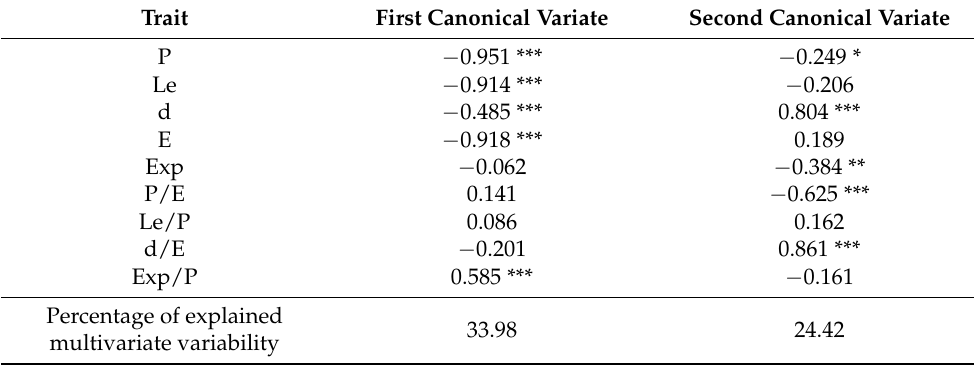
Figure 7. Heatmap for Pearson’s correlation coefficients between observed traits (r cr = 0.232) for Rubus species. The heatmap shows a graphical representation of the correlation matrix between pairs of observed traits. Every element of the correlation matrix is presented by a darkened square indicating the value at that location, using another color or darkening density. P–length of the polar axis, Le–length of the ectoaperture, d–the distance between apices of two ectocolpi, E–equatorial diameter, P/E–length of the polar axis and equatorial diameter ratio, Le/P–the ratio of the length of the ectoaperture and length of the polar axis. Table 7. Correlation coefficients between the first two canonical variables and original